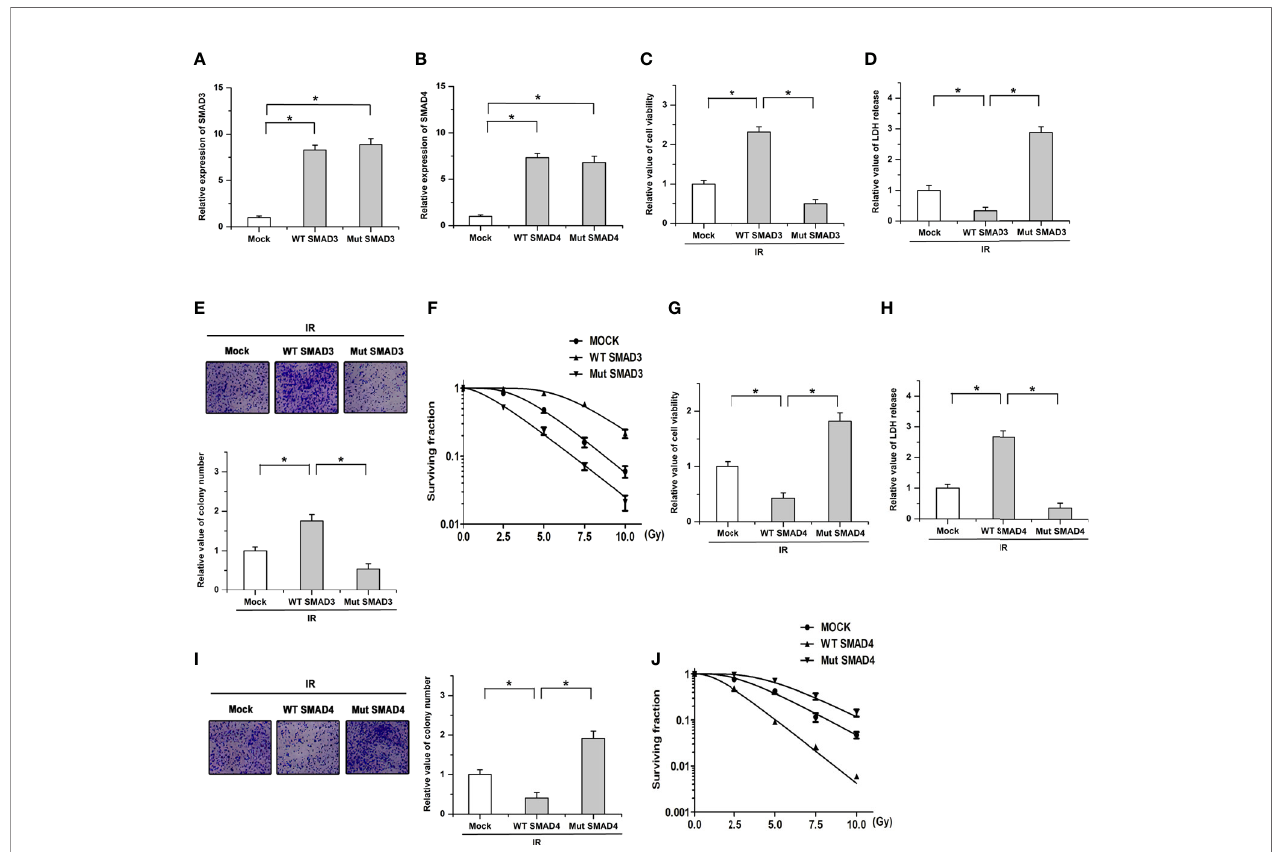
FIGURE 4 | The radiosensitivity is affected by the mutation of SMAD3 or SMAD4 in PDAC. (A, B) Results of qPCR showed that there were no obvious differences on the expression of SMAD3 (A) or SMAD4 (B) between the WT and Mut cells, respectively. (C, D) The regulatory effects of IR on cell viability (C) and LDH release (D) were facilitated by the SMAD3 mutation. (E, F) The decreases of colony formation (E) and surviving fraction (F) induced by IR were enhanced by the mutation of SMAD3 compared with the WT group. (G, H) SMAD4 mutation mitigated the effects of IR on cell survival (G) and LDH release (H) . (I, J) The decrease of colony formation (I) and surviving fraction (J) induced by IR were antagonized by SMAD4 mutation compared with the WT group. Cells infected with the empty vector were de fi ned as the mock group. *P <